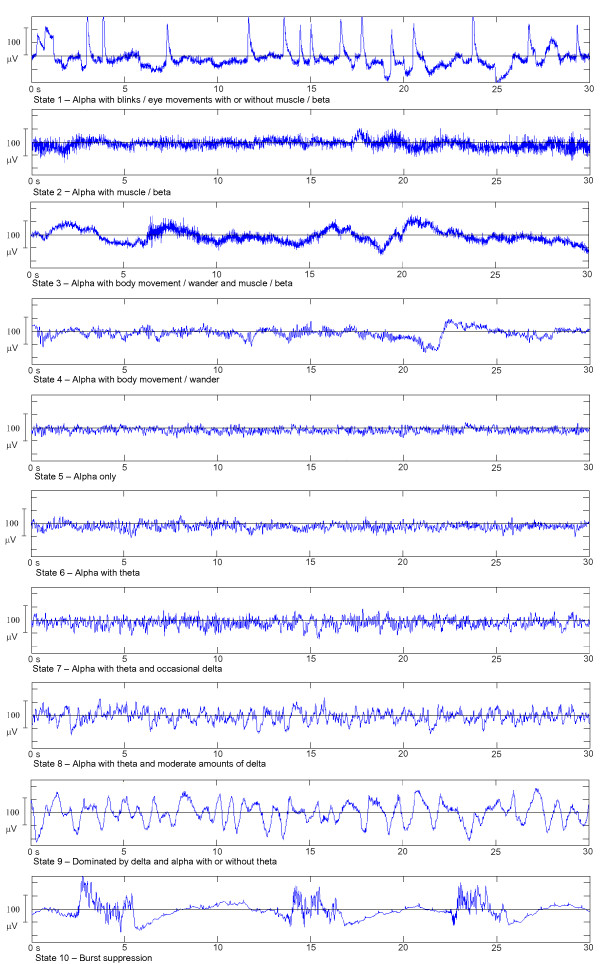
Examples of EEG states relating to deepening sedation. Ranging from awake (states 1 - 4) to burst suppression (state 10). The raw EEG is recorded via ASCII protocol from the BIS unit. These are typical examples from the current dataset and therefore from an anaesthetic regimen of bolus induction (either propofol or thiopentone) and inhalational maintenance (sevoflurane, isoflurane or desflurane).